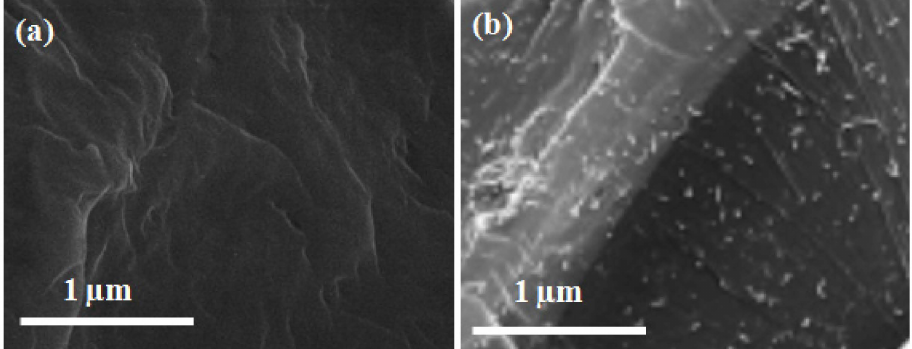
Figure 3. Scanning electron microscopy images of ( a ) pure urea-formaldehyde resin at 50 k and ( b ) MWCNTs-UF resin at 50